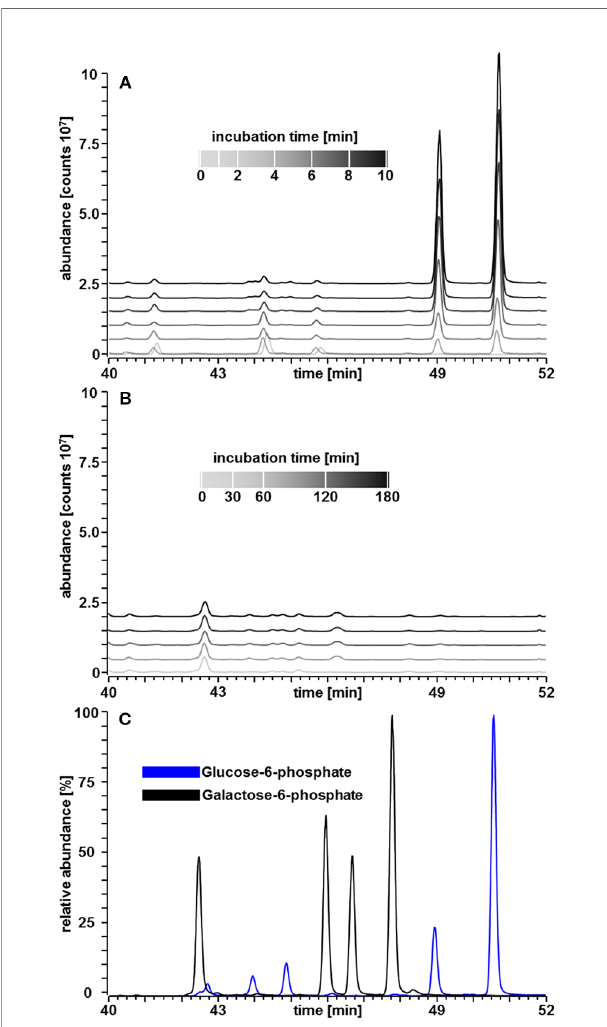
FIGURE 5 | GC – MS chromatograms of sugar phosphates. (A) Linear increase in Glc-6P area over time in a PGM assay with Glc-1P (200 µM) as substrate. (B) Amounts of Gal-6P in a PGM assay with Gal-1P (200 µM) as substrate instead of Glc-1P. Gal-6P was below the limit of detection of about